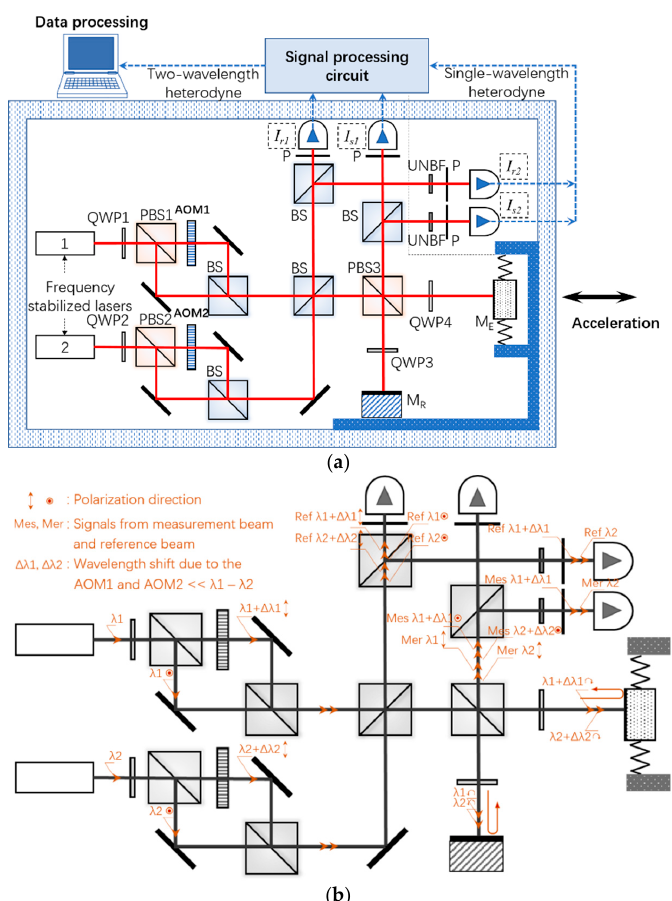
Figure 1. ( a ) Schematic diagram of optical acceleration measurement method based on synthetic wavelength and single wavelength superheterodyne detection. QWP, quarter-wave plate; PBS, polarization splitting prism; AOM, acousto-optical modulator; BS, beam splitter; P, polarizer; UNBF, ultra-narrow bandwidth filter; M R , micro mirror; M E , micromachined elastic structure. ( b ) Optical layout of the configuration with marks of polarization direction and wavelength of the laser